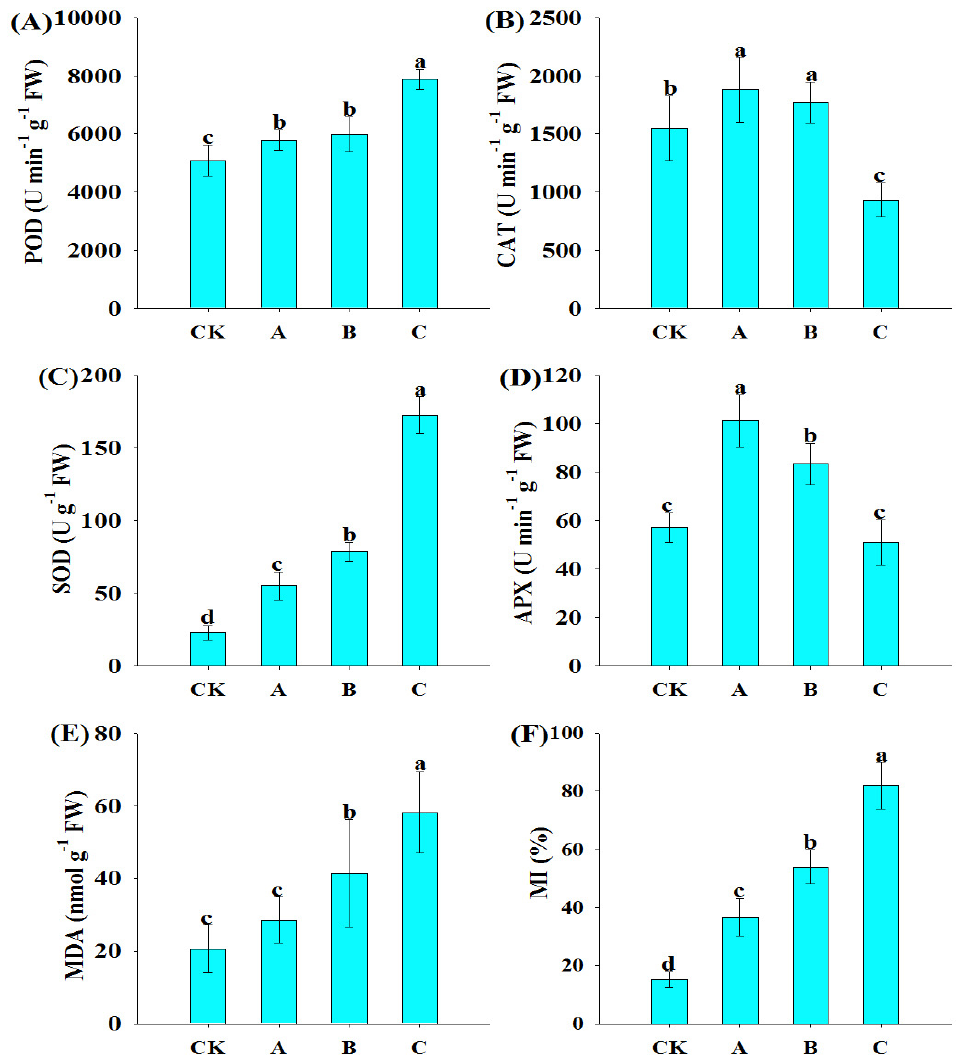
Figure 6. Effects of salinity and alkalinity stress on ( A ) peroxidases (POD), ( B ) catalase (CAT), ( C ) superoxide dismutase (SOD), ( D ) ascorbate peroxidase (APX) activities, ( E ) malondialdehyde (MDA) content, ( F ) membrane permeability (MI). The bars represent the standard errors ( ± SE) of the four replicates. Different letters on the column represent significant difference among treatments ( p ≤ 0.05).